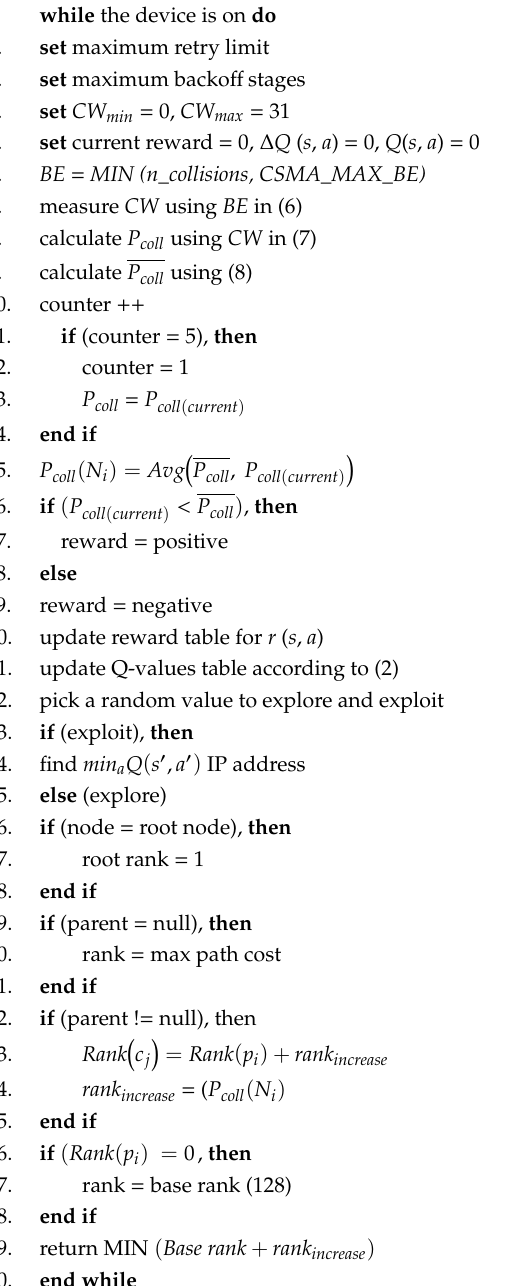
Algorithm 1: Cross-layer optimization for low-power and lossy networks using i CPLA